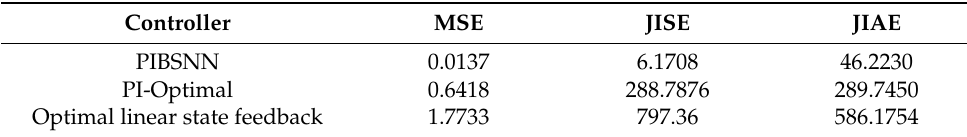
Figure 13. Adaptive control parameters are computed by the B-spline neural network.